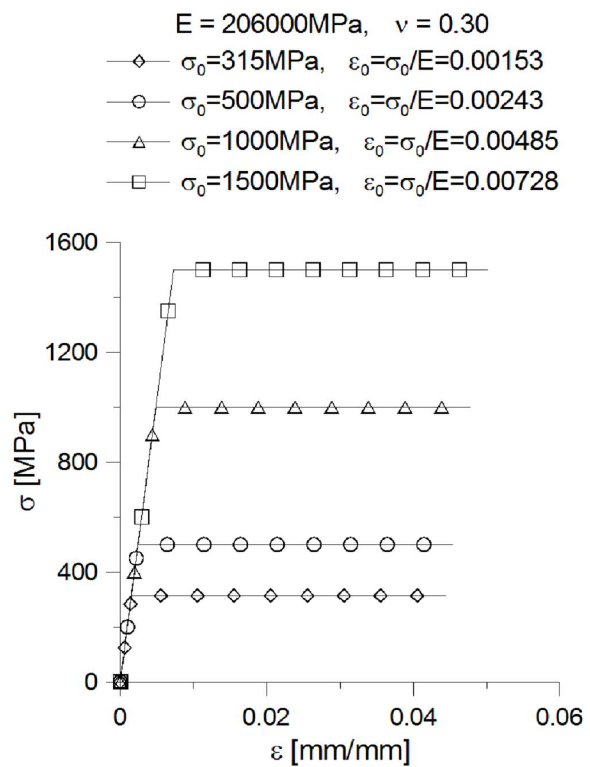
Figure 4: Graphical representation of the elastic-ideally plastic material models used to calculate the limit loads